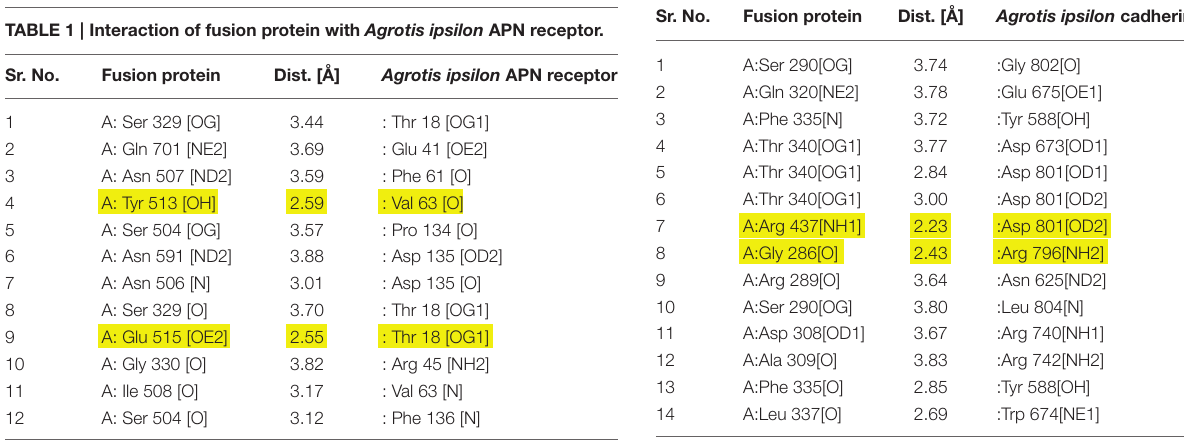
Frontiers in Plant Science |